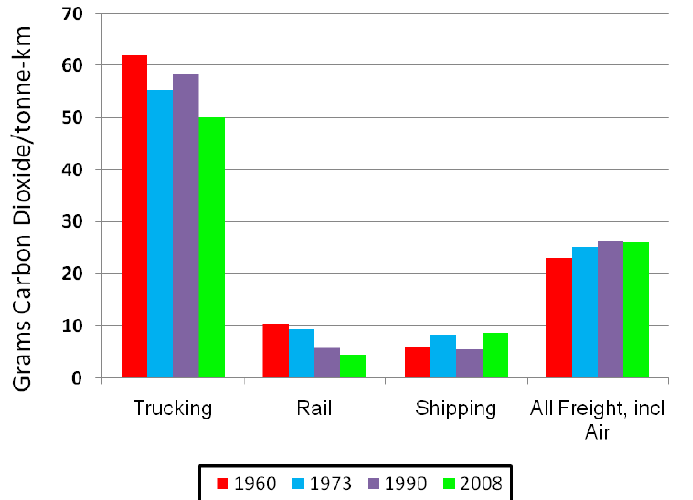
Figure 9. Carbon Intensities of Freight, by